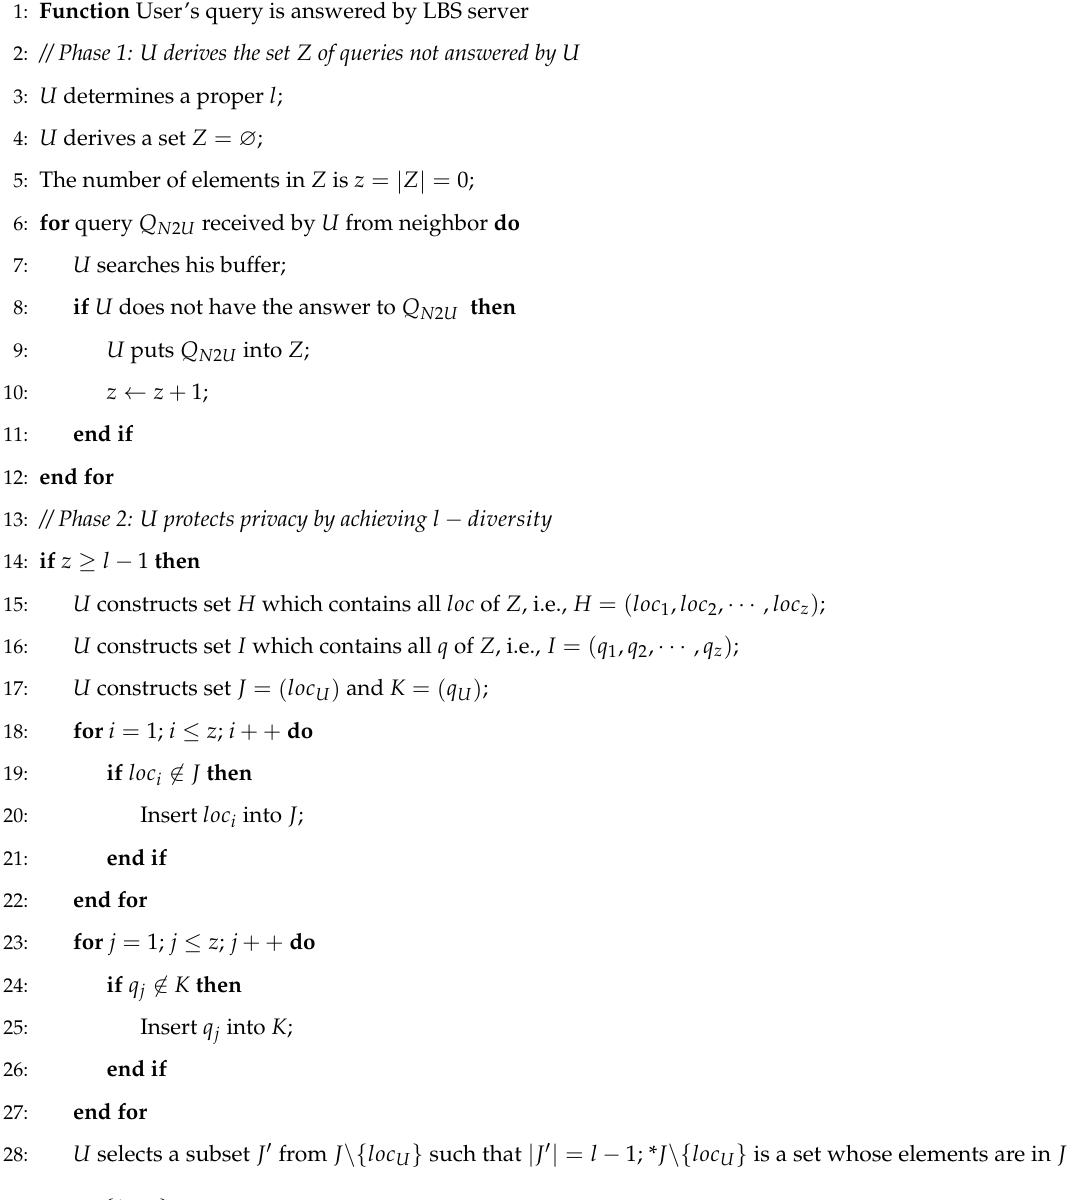
Algorithm 2 : Query to LBS Server